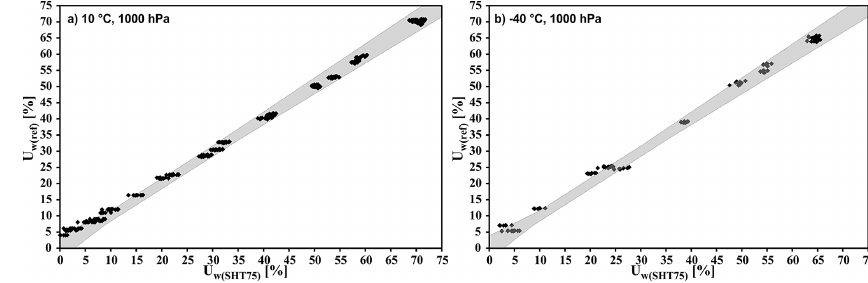
Figure 6. U w ( SHT75 ) values of all SHT75 sensors at 1000hPa for (a) 10 ◦ C and for (b) − 40 ◦ C.